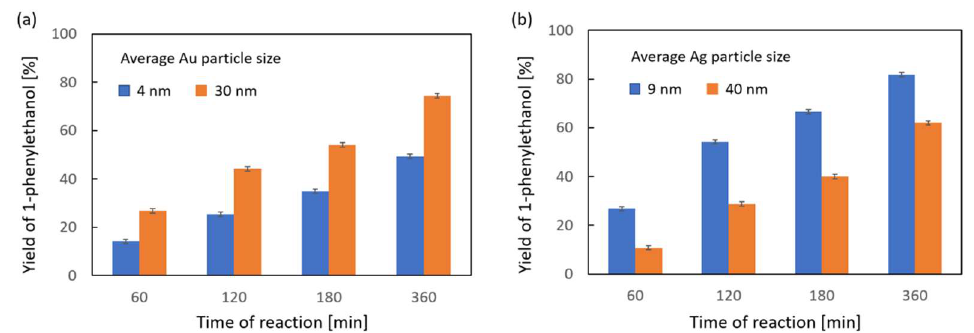
Figure 4. Effect of particle size on the yield of 1-phenylethanol obtained during catalytic transfer hydrogenation of acetophenone with 2-pentanol in the presence of ( a ) Au/Ce 0.85 Zr 0.15 O 2 and ( b ) Ag/Ce 0.85 Zr 0.15 O 2 .